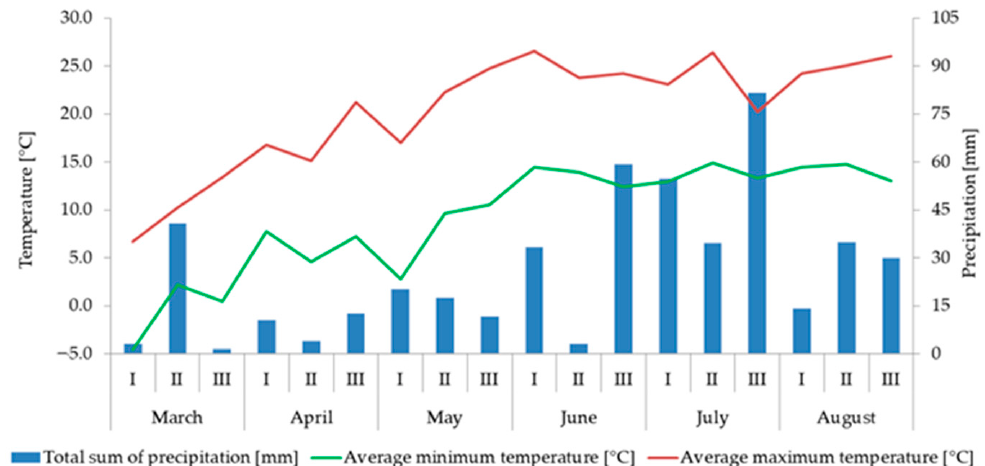
Figure 1. Decade weather condition in 2011 with marking minimum and maximum temperature.